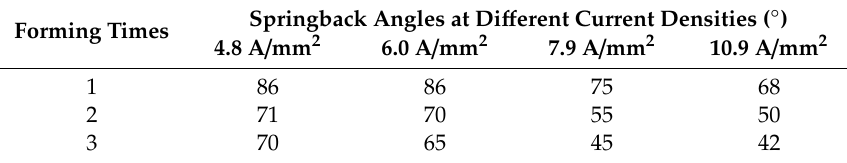
Table 1. The effects of forming times and current density on springback angles. Table 1. The e ff ects of forming times and current density on springback angles. Forming